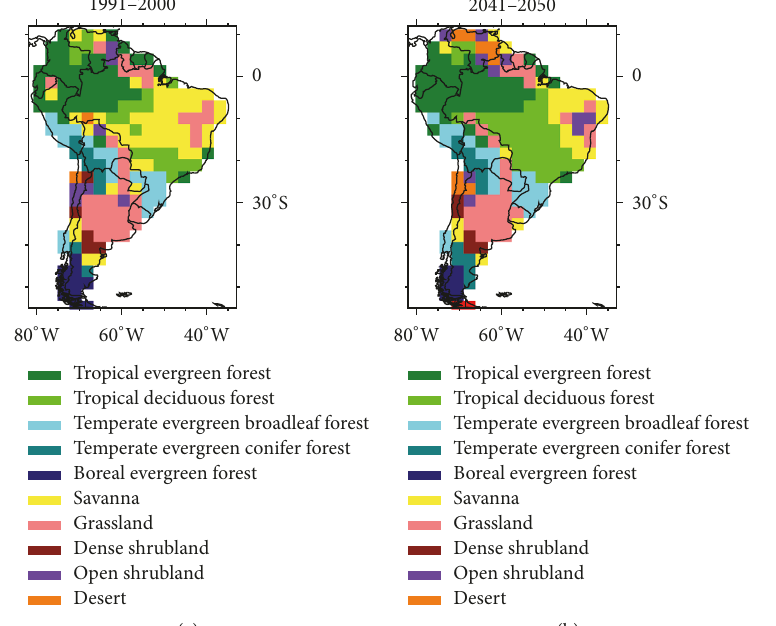
Figure 4: Vegetation cover in South America over (a) present-day conditions (1991–2000) and (b) future scenario (2041–2050).